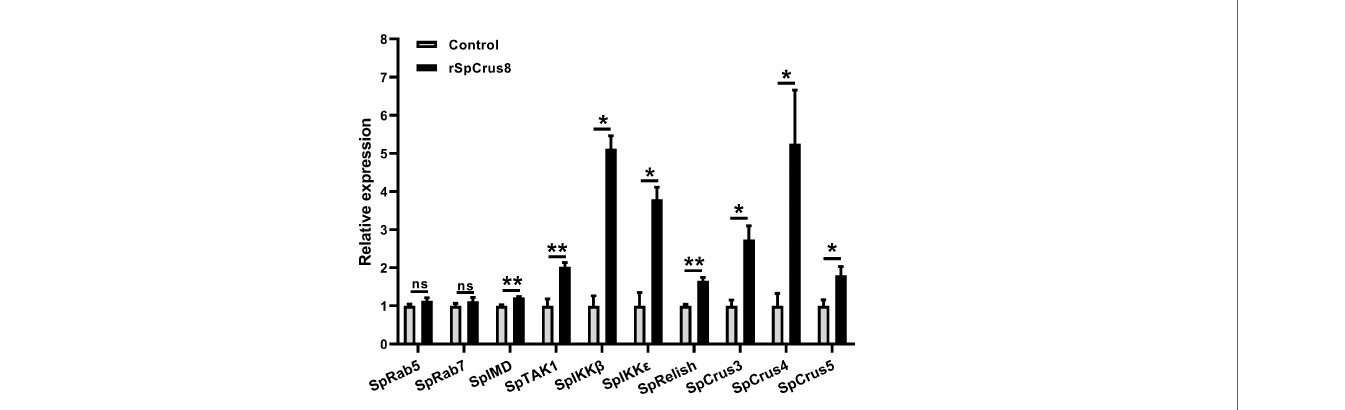
FIGURE 7 | The regulatory role of SpCrus8 in hemocytes of S. paramamosain . The expression of immune-related genes (SpRab5, SpRab7, SpIMD, SpTAK1, SpIKK b , SpIKK ϵ , SpRelish, SpCrus3,SpCrus4 and SpCrus5) in hemocytes were examined (n=3) after being treated with rSpCrus8. Signi fi cant difference was indicated with asterisks, *p < 0.05 and, **p < 0.01 and ns represented no signi fi